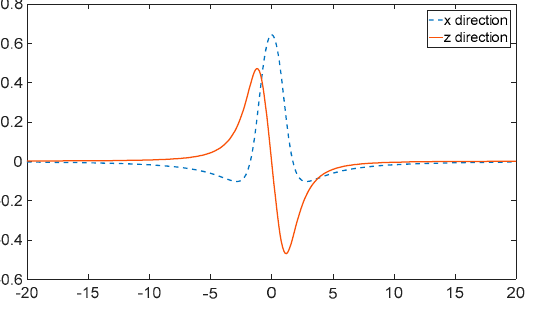
Figure 3. MFL of a defect.